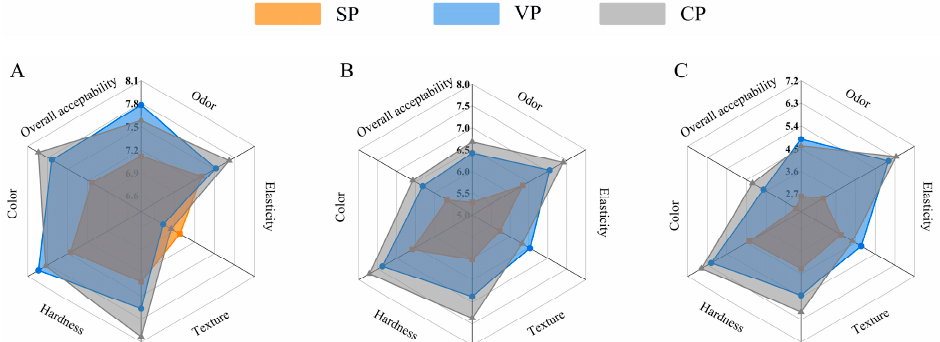
Figure 1. Sensory evaluation of SP, VP, and CP samples after 4 days ( A ), 6 days ( B ), and 10 days ( C ) (as representatives) of chilled storage, respectively. SP, simple packaging; VP, vacuum packing; and CP, stable chlorine dioxide pretreatment combined with vacuum packing.